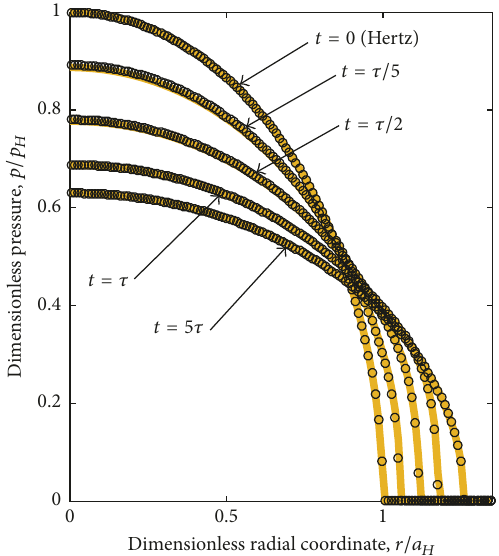
Figure 5: Comparison of pressure history in the step loading spherical indentation of a Zener half-space.